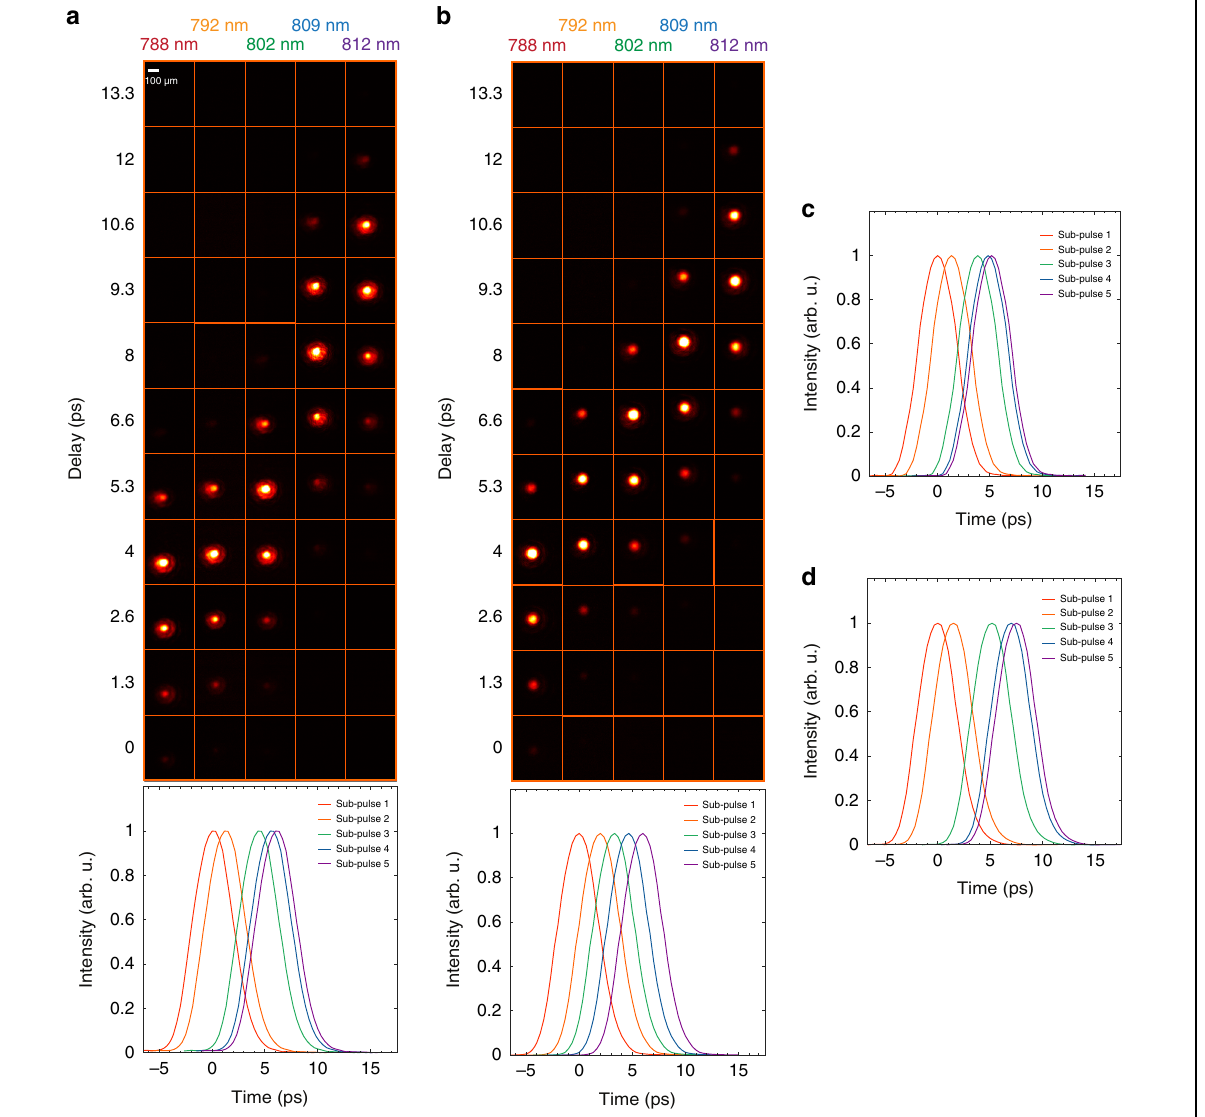
Fig. 7 Temporal characterization of the system using OKG pump-probe experiments. a Images of the OKG as a function of the delay between the pump and the image pulse train for a 2 = 40,000 fs 2 without group delay adjustment ( top ) and the corresponding transmittance (bottom). b Images of the OKG as a function of the delay between the pump and the image pulse train for a 2 = 40,000 fs 2 with group delay adjustment (top) and the corresponding transmittance (bottom). c Transmittance of the OKG as a function of the delay between the pump and the image pulse train for a 2 = 20,000 fs 2 . d Transmittance of the OKG as a function of the delay between the pump and the image pulse train for a 2 = 60,000 fs 2